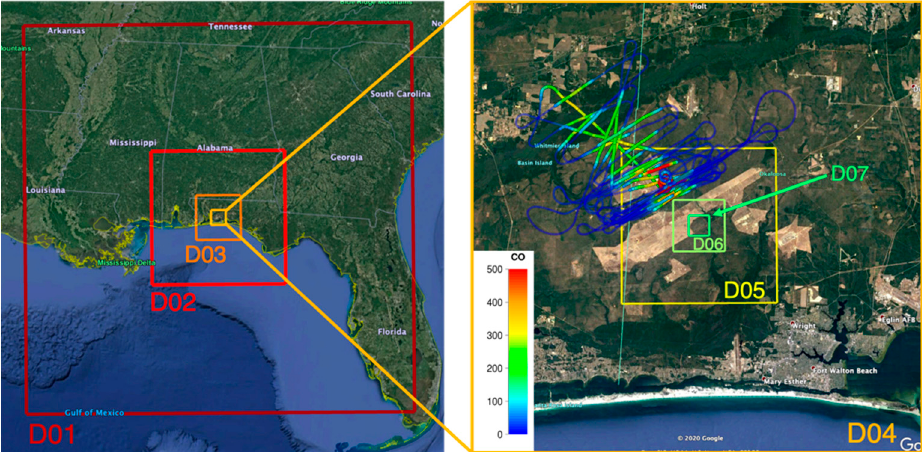
Figure 2. WRF-SFIRE domain configuration centered over the L2F burn plot. Colored dots represent downwind CO enhancements (ppb).